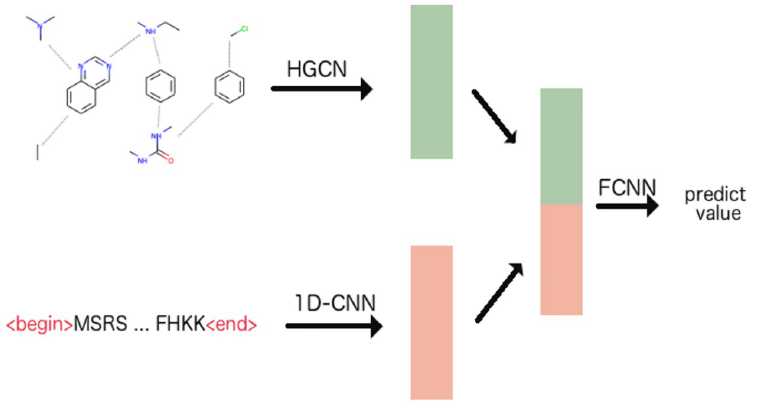
Fig 4. An overview of the CPI prediction model which encodes compounds using a HGCN and proteins using a 1D-CNN. FCNN denotes a fully-connected neural network, predicting the interaction based on a compound embedding and a protein embedding, which are generated from previously described components. We use the initial embedding layers with 64 dimensions and generate 128-dimension vectors for both compounds and proteins.